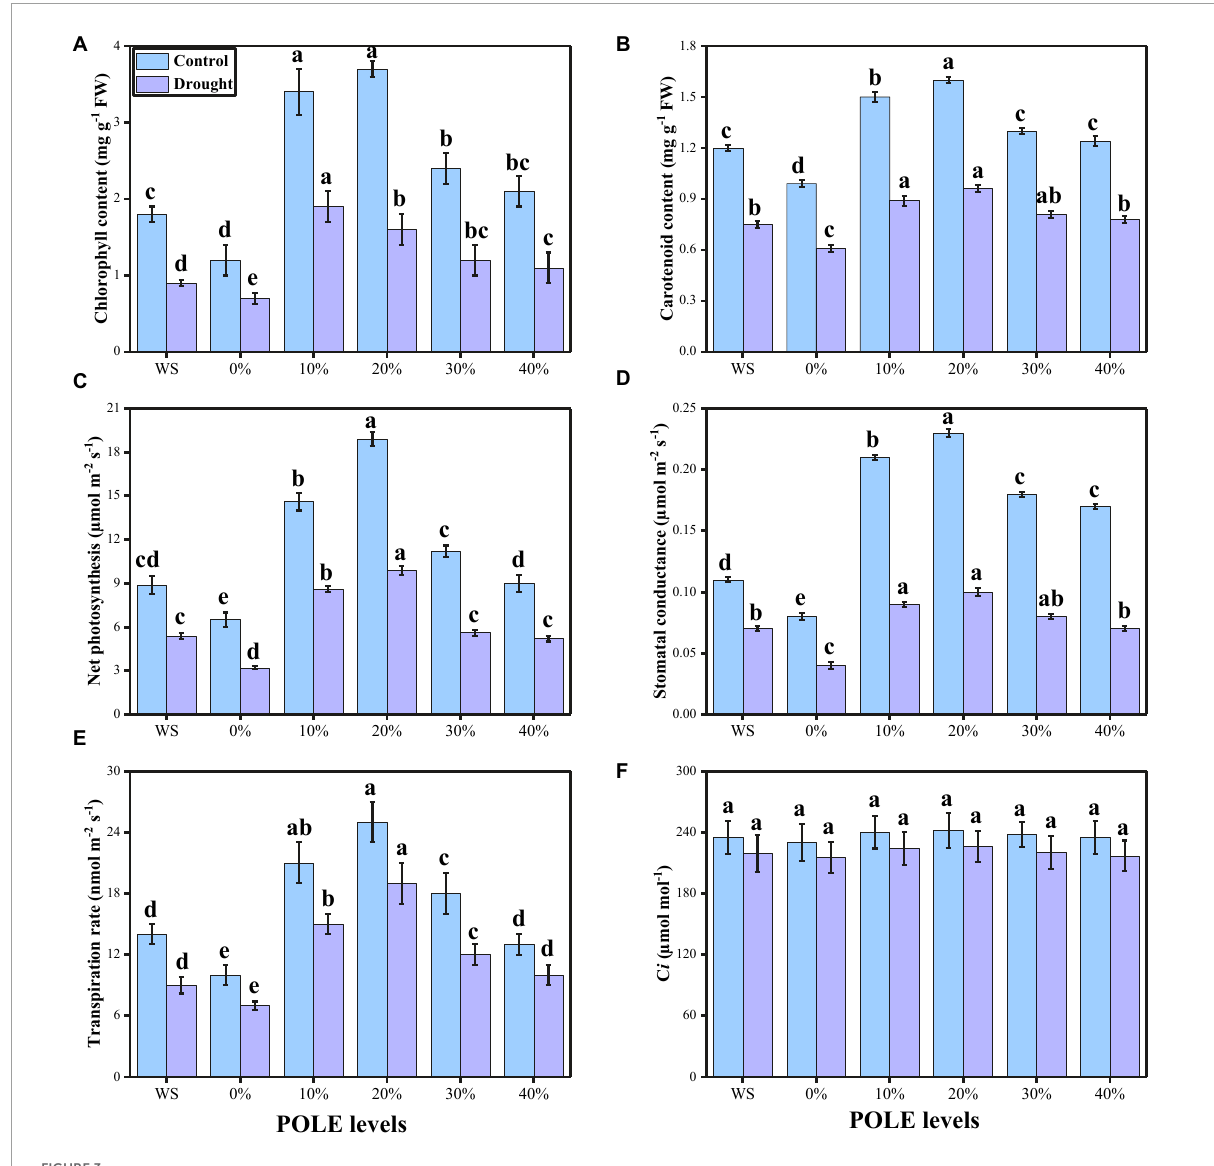
FIGURE3 Effect of seed priming with Plantago ovata Forsk leaf extract (POLE) on total chlorophyll contents (A) , carotenoid contents (B) , net photosynthesis (C) stomatal conductance (D) , transpiration rate (E) , and intercellular CO 2 (F) under well-watered and drought-stressed environment in wheat. Means sharing similar letter(s) within a column for each parameter do not differ significantly at P < 0.05. Data in the figures are means of four repeats ( n = 4) of just one harvest of wheat plants ± standard deviation (SD). Different lowercase letters on the error bars indicate significant difference between the treatments. Different treatments of POLE used in this study are as follows: WS (Control, without POLE + without water), 0% (0% POLE), 10% (10% POLE), 20% (20% POLE), 30% (30% POLE), and 40% (40%